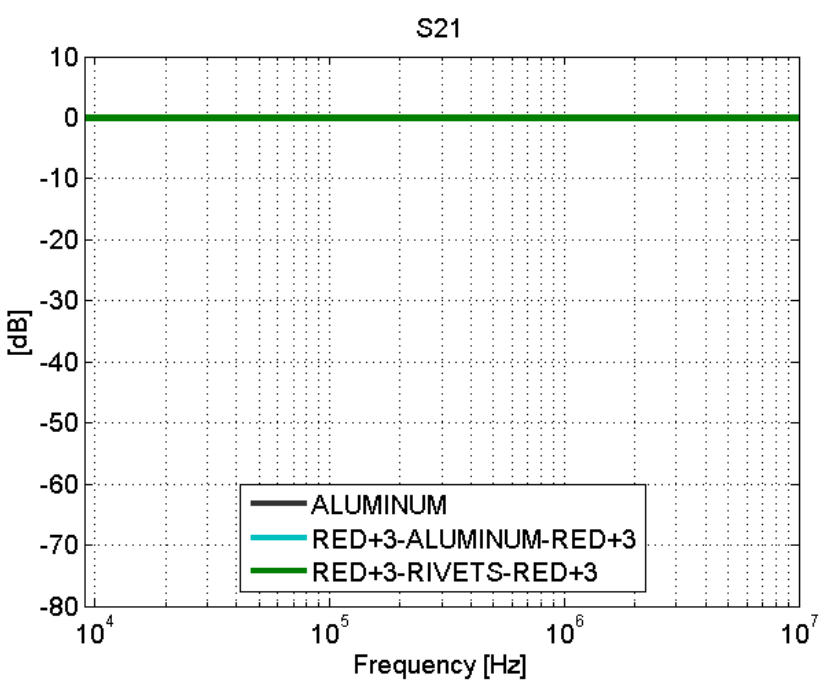
Figure 13. Scattering parameters test: S 21 . Fastener